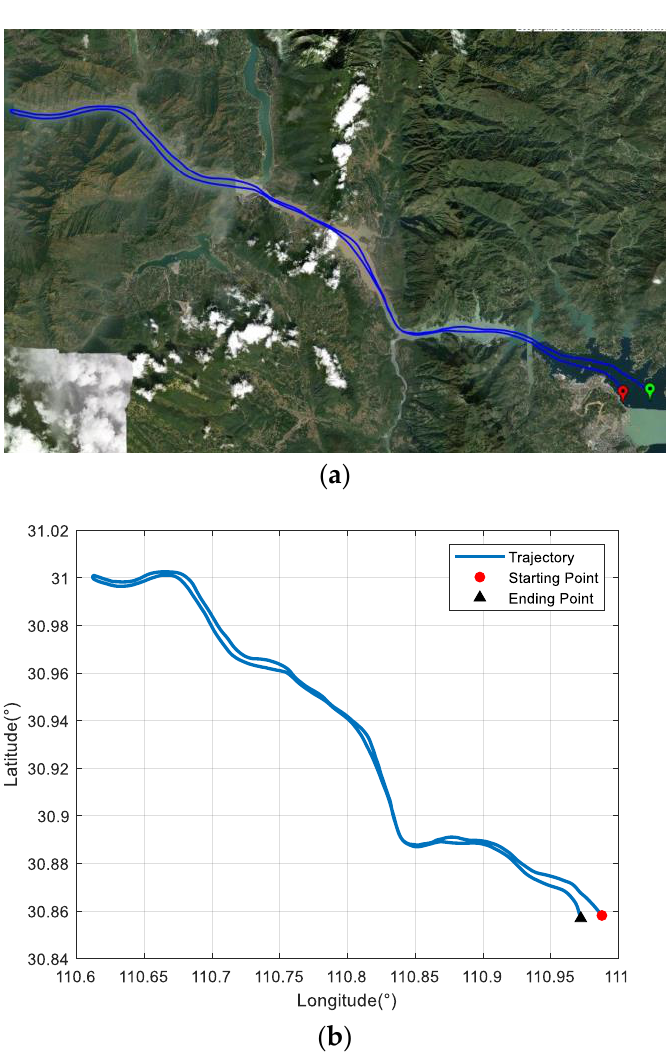
Figure 4. Ship trajectory at mid-latitudes: ( a ) planned route in Google Maps; ( b ) actual navigation trajectory.